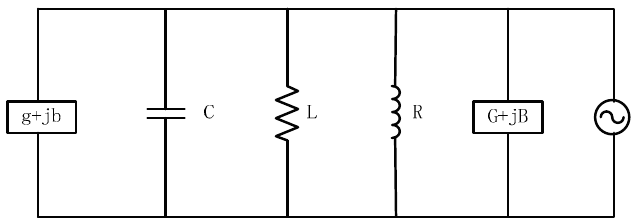
Figure 2. The equivalent circuit model of magnetron is being locked by an external signal.